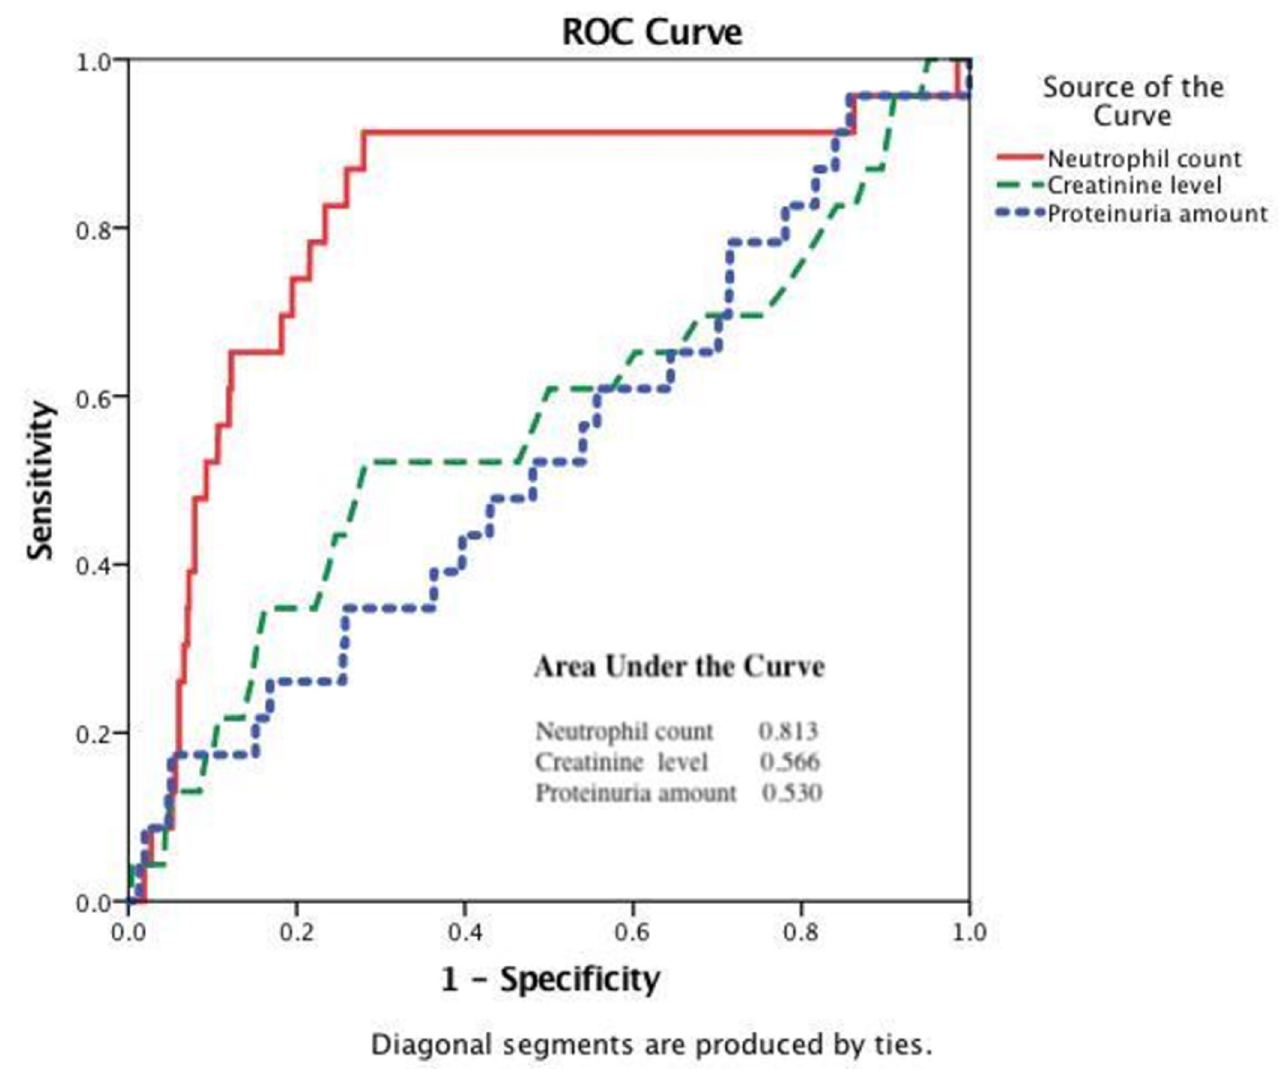
Fig 2. The receiver operating characteristic curves and the area under the peripheral neutrophil count, serum creatinine, and proteinuria amount for discriminating study population with and without rapid